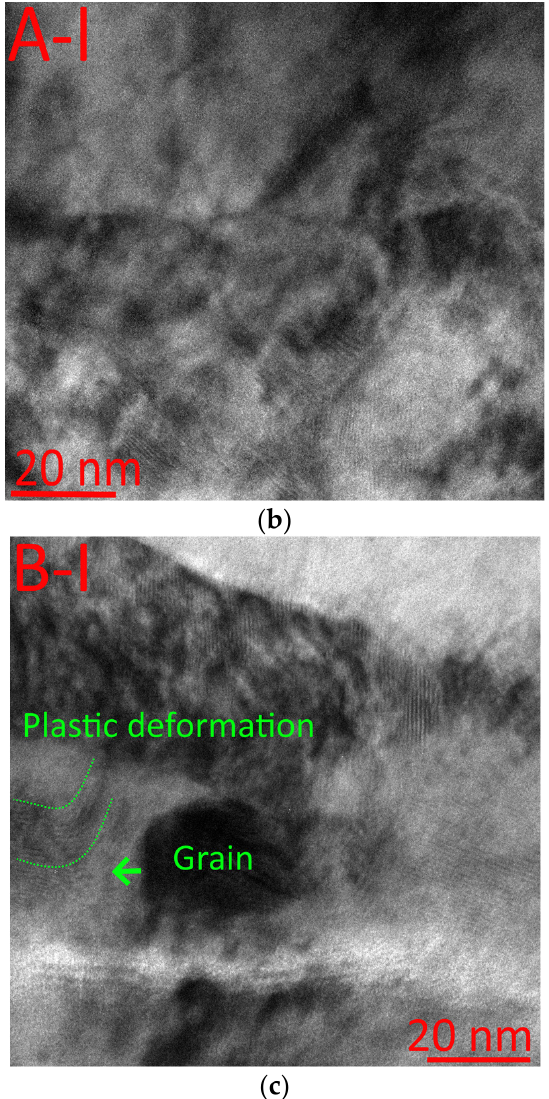
Figure 4. Deformation in the structure of nanolayers of the Cr,Mo-(Cr,Mo)N-(Cr,Mo,Al)N coating under the influence of the cut material flow. ( a ) General view of the investigated coverage area; ( b ) Deformation of the outer layers of the coating under the influence of a moving layer of the cut material; ( c ) Deformation of coating nanolayers under the influence of grains of cut material introduced into the structure.